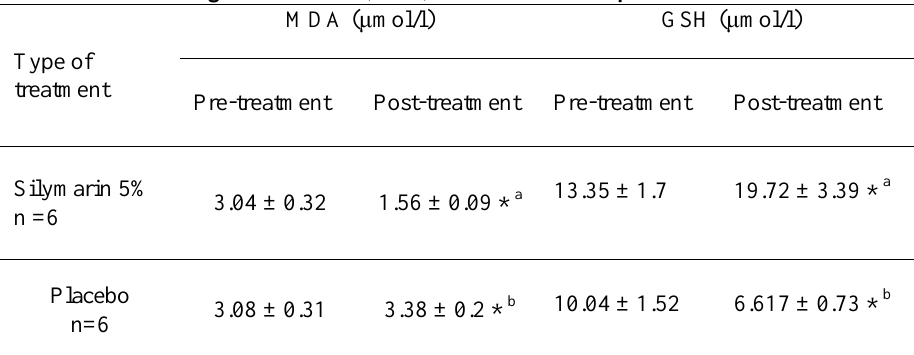
Table 3. Effects of silymarin 5% paste on serum malondialdehyde (MDA) and glutathione (GSH) contents in HLU